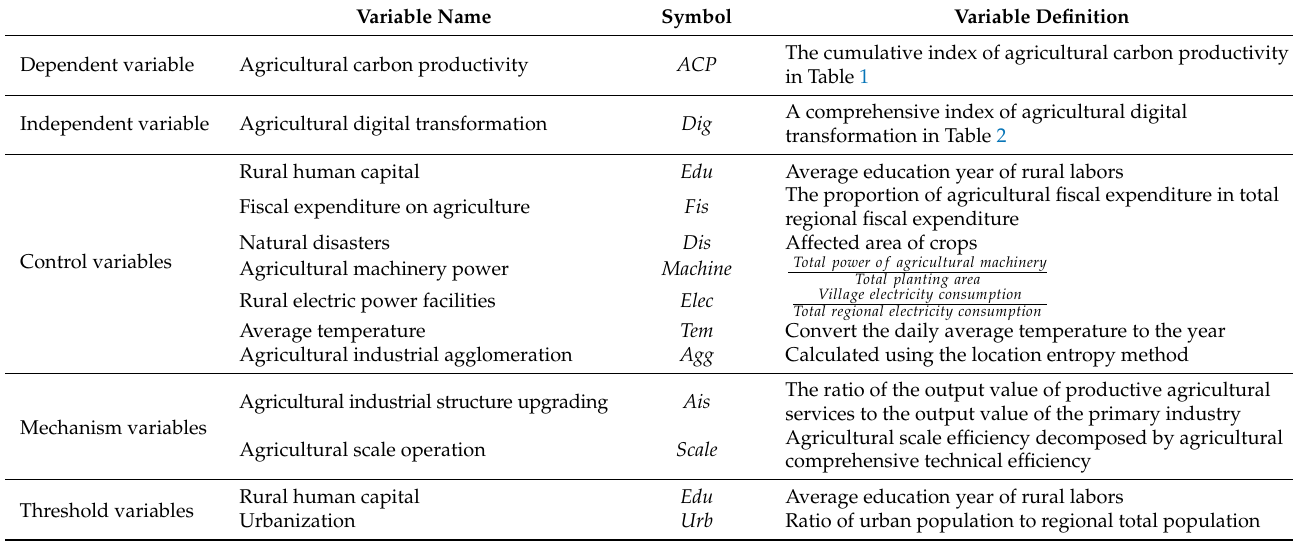
Table 3. Variable